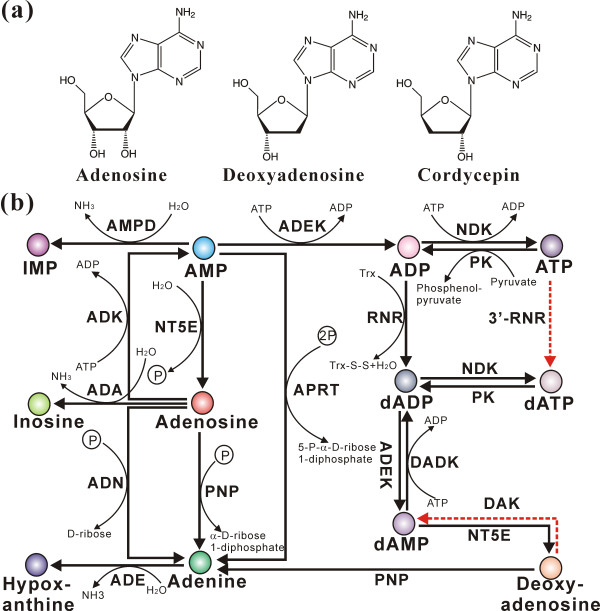
Cordycepin analogues and the C. militaris adenine metabolic pathway. (a) The structures of cordycepin analogues. (b) The C. militaris adenine metabolic pathway. Abbreviations for different enzymes: ADA, adenosine deaminase; ADE, adenine deaminase; ADEK, adenylate kinase; ADK, adenosine kinase; ADN, adenosine nucleosidase; AMPD, AMP deaminase; APRT, adenine phosphoribosytransferase; DADK, deoxyadenylate kinase; DAK, deoxyadenosine kinase; NDK, nucleoside-diphosphate kinase; NT5E, 5'-nucleotidase; PK, pyruvate kinase; PNP, purine nucleoside phosphorylase; 3'-RNR, ribonucleotide triphosphate reductase. The red dashed lines show metabolic pathways present in other organisms but absent in C. militaris.